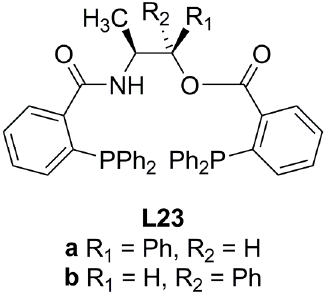
Figure 9. Ephedrine derivated ligands.